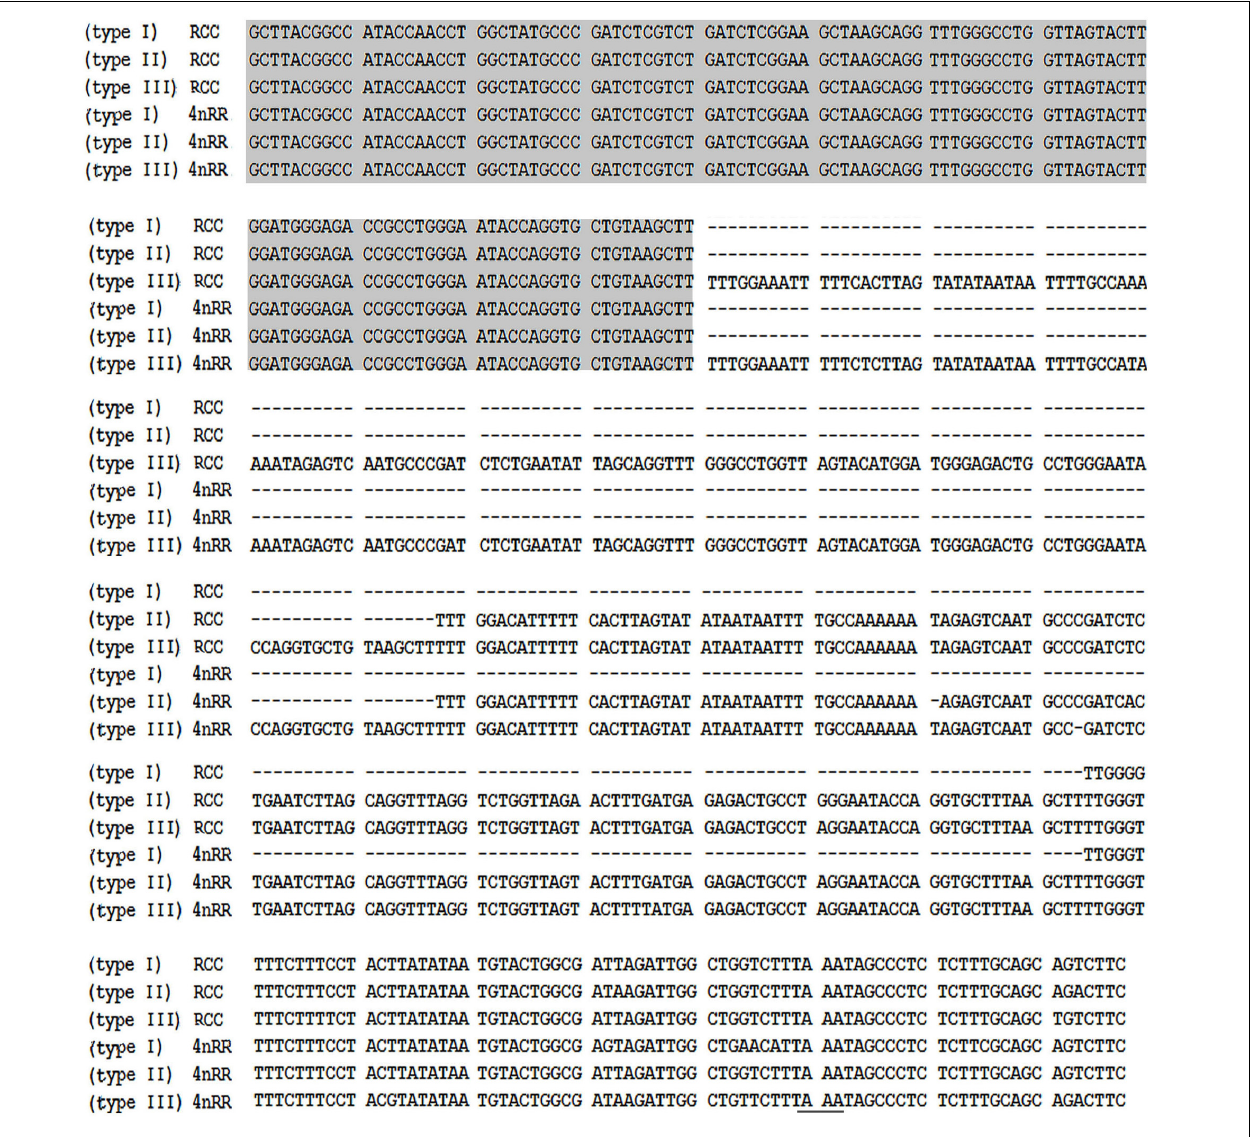
FIGURE 2 | Representative sequences of 5S rDNA from RCC and 4 n RR. Complete 5S coding regions are shaded; the NTS upstream TATA elements are underlined.